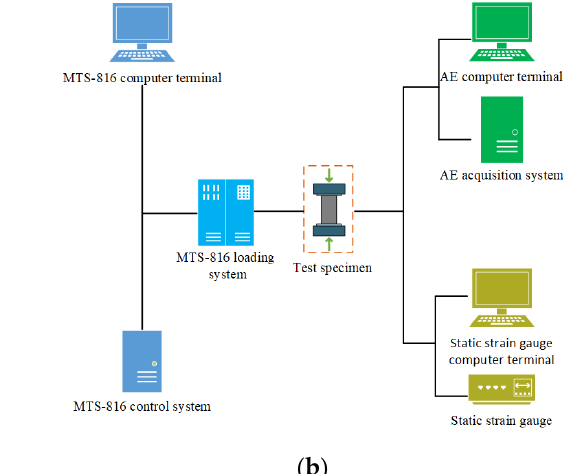
Figure 2. Sensor layout on the surface of specimen. The acquisition parameters of the AE system for this study were set as shown in Table 1. Table 1. Acquisition parameters of the AE system. Parameter